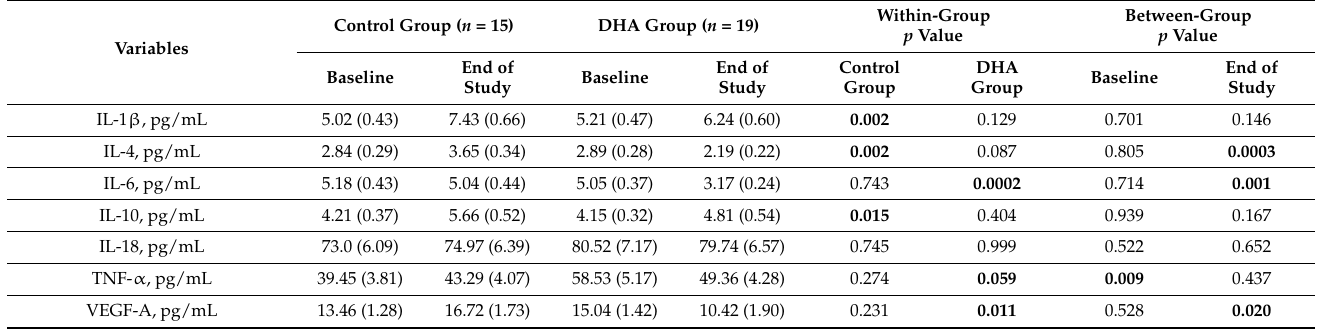
Table 5. Variables related to inflammation at baseline and at the end of the study in patients treated with the DHA supplement and in controls.